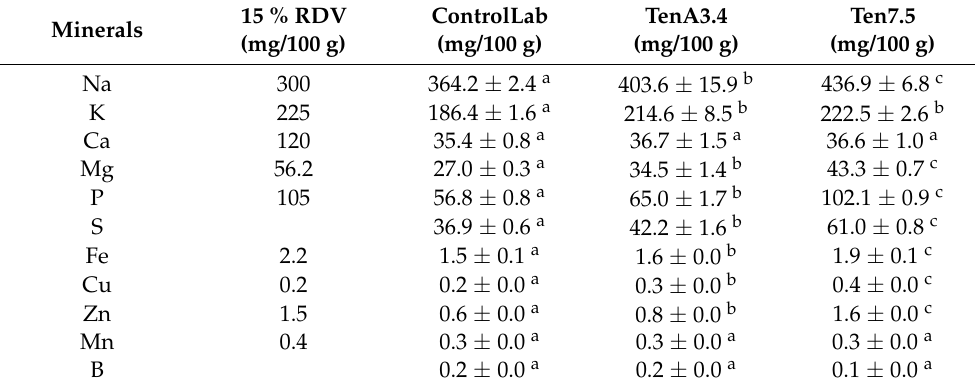
Table 4. Mineral composition (mg/100 g) of sauces with the incorporation of different proportions of T. molitor flour (3.4% and 7.5%) and comparison with control samples (0%). Mean values with different letters in the same row are significantly different (Tukey’s test, p < 0.05). Minerals